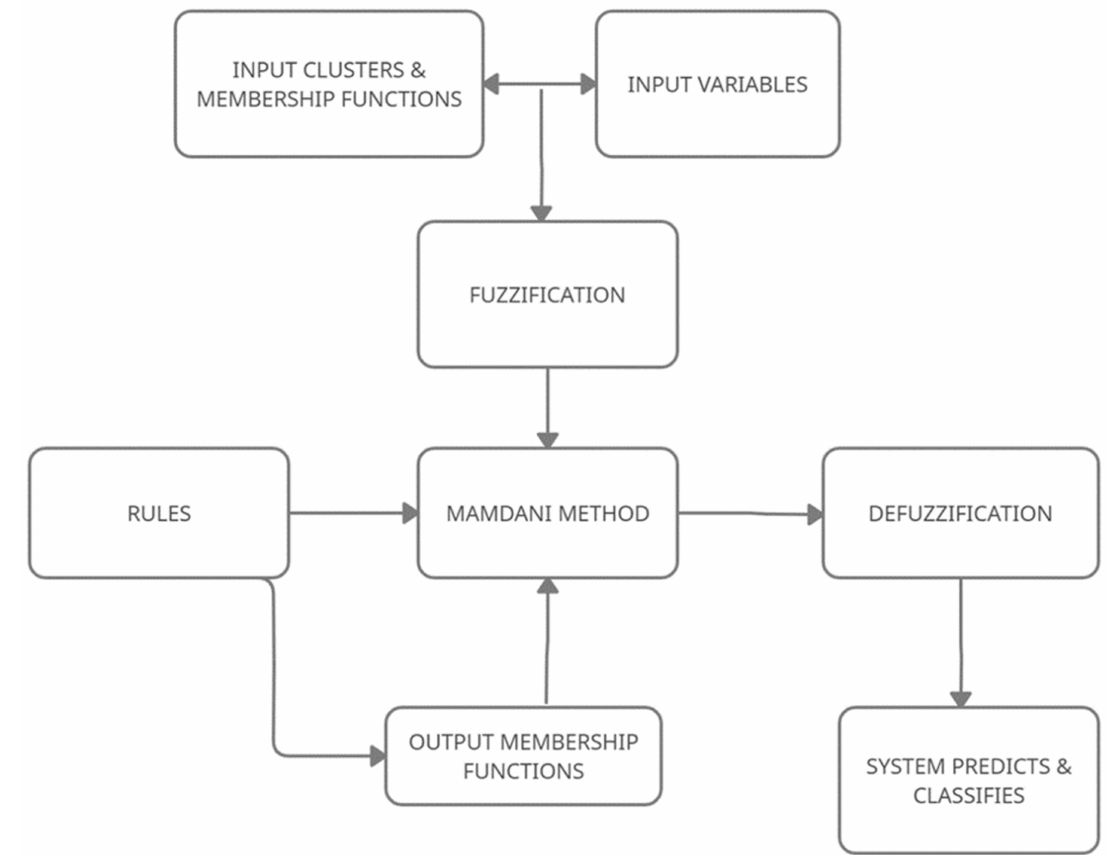
Figure 1. The flowchart of the Fuzzy logic